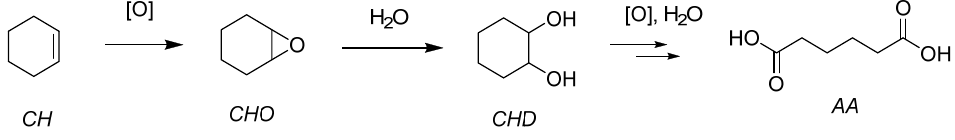
Figure 24. Epoxidation of cyclohexene leading to adipic acid. Table 12. Results of AA formation according to substrate using molecular of grafted POM-based catalysts from Figure 23.